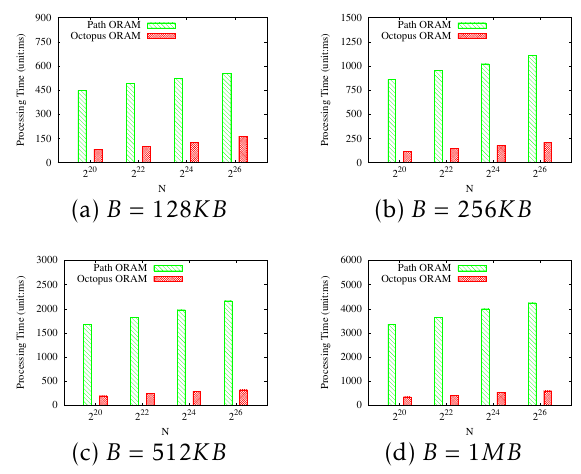
Figure 9. Comparing the Processing Time per Query between Octopus ORAM and Path ORAM.